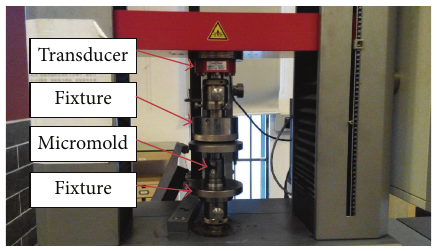
Figure 3: Microextrusion